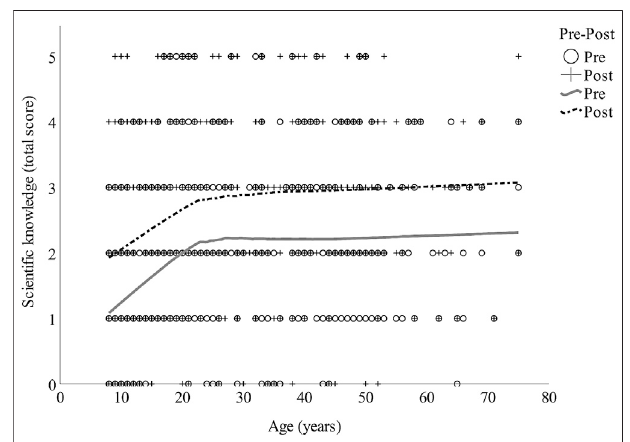
FIGURE 1 | Scatter plot with LOESS regressions (smoothing parameter α (cid:1) 0.70)forscienti fi ccontentknowledgeasafunctionofage,beforeandafter the visit ( N (cid:1) 451) at T ū